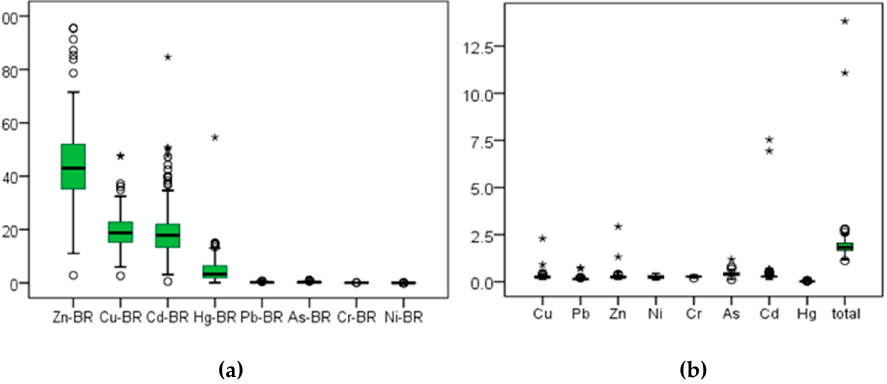
Figure 3. Box plots of the ( a ) bio-accumulation rates and ( b ) comprehensive pollution levels. (“ * ” represent the outlier value).